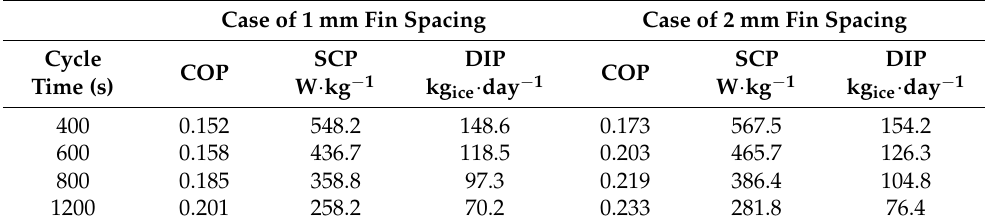
Table 3. The performance indicators of the finned-tube base model at 2 mm fin height.